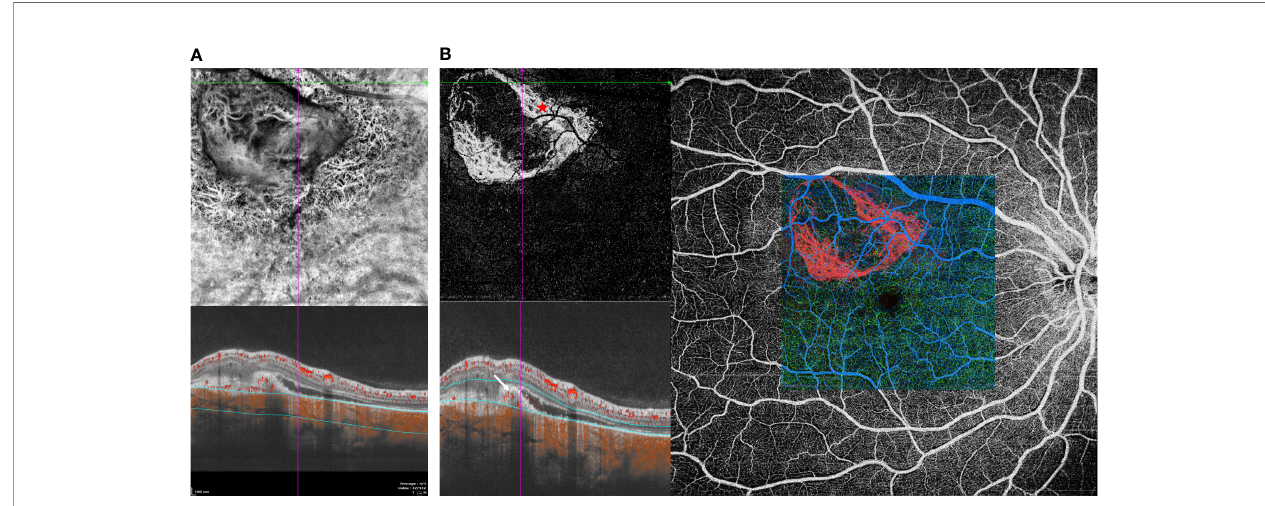
FIGURE 4 | (Patient 3) (A) SS-OCTA showed SFVNs with tangled vascular structures that corresponded to the tumor-related vasculature seen on FA/ICGA ( eFigure 4B ). (B) Type 2 neovascularization and tumor-related vasculature were seen when the boundary layers on the cross-sectional SS-OCTA B-scan transitioned from the top of the lesion to